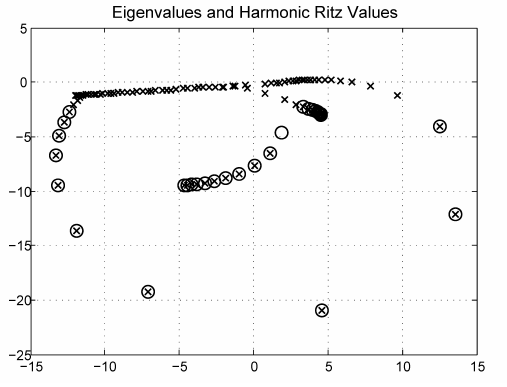
Figure 6: The first 30 eigenvalues of the system matrix with the smallest imaginary part (circles) and the first 100 har- monic Ritz values (crosses) for the golden strip